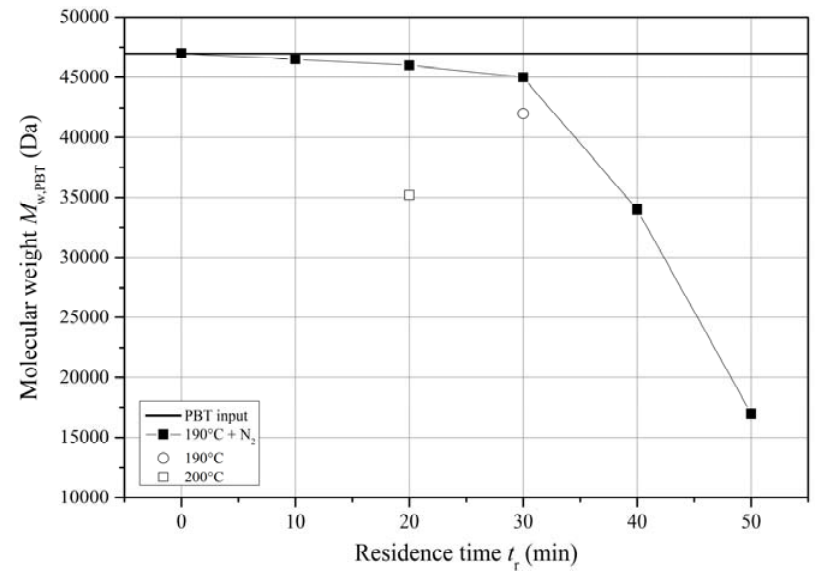
Figure 4. Diagram showing the molecular weight M w,PBT of the polymer depending on the residence time t r during dissolution process using CreaSolv ® 2 with and without the exclusion of oxygen. PBT, polybutylene terephthalate.